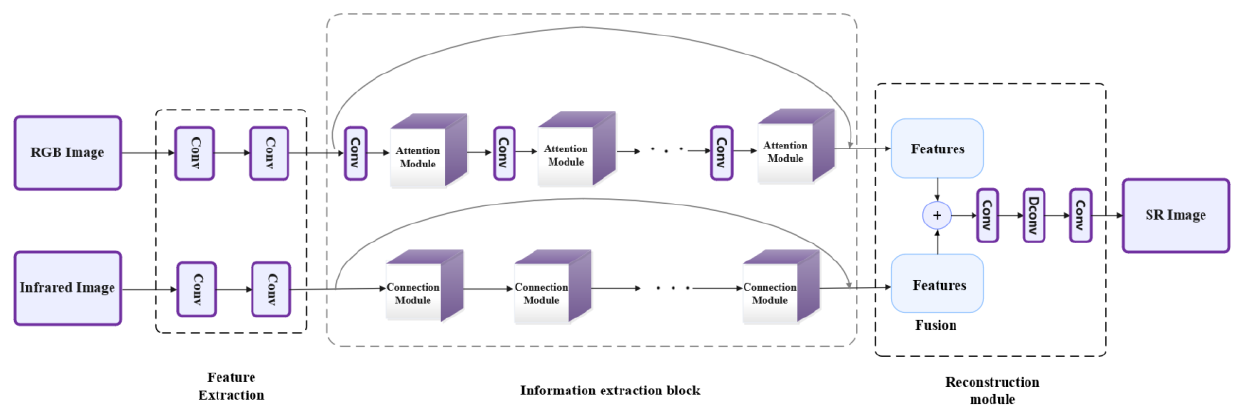
Figure 5. The architecture of the proposed